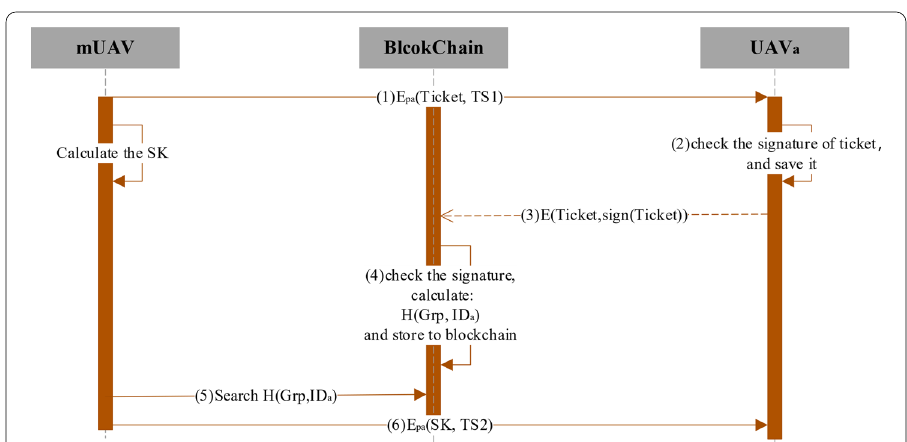
Fig. 2 Blockchain-based authentication for group building. This figure shows the process of authentication for group building and